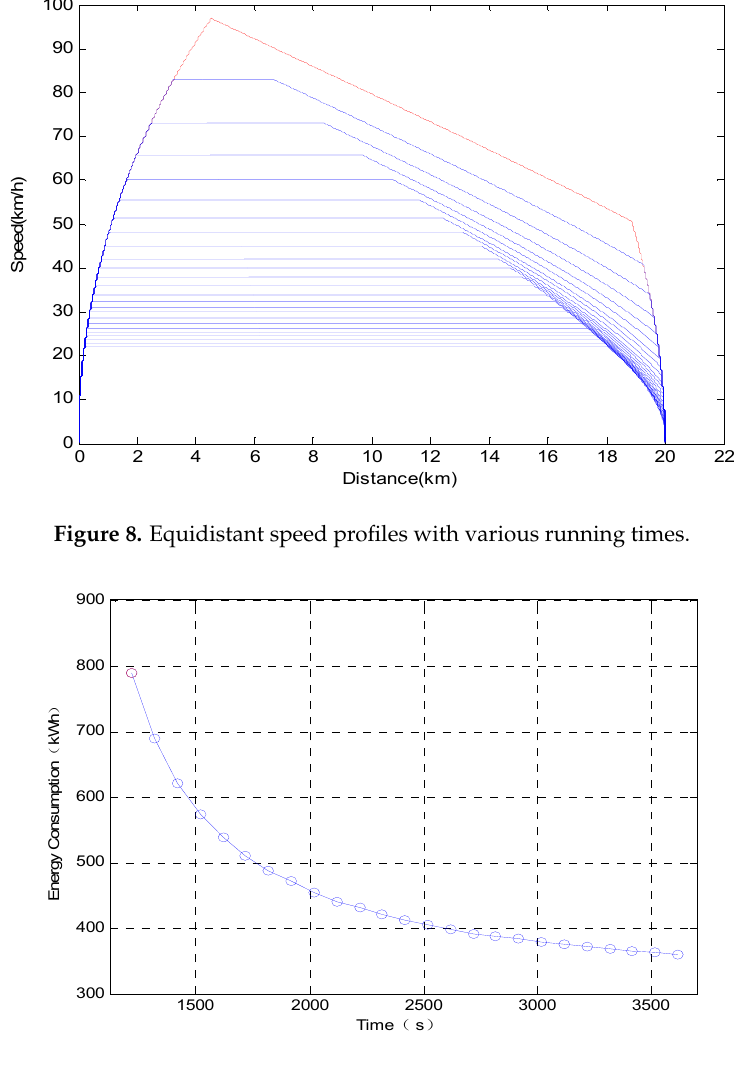
Figure 9. Energy consumptions for various operation strategies with different running times.